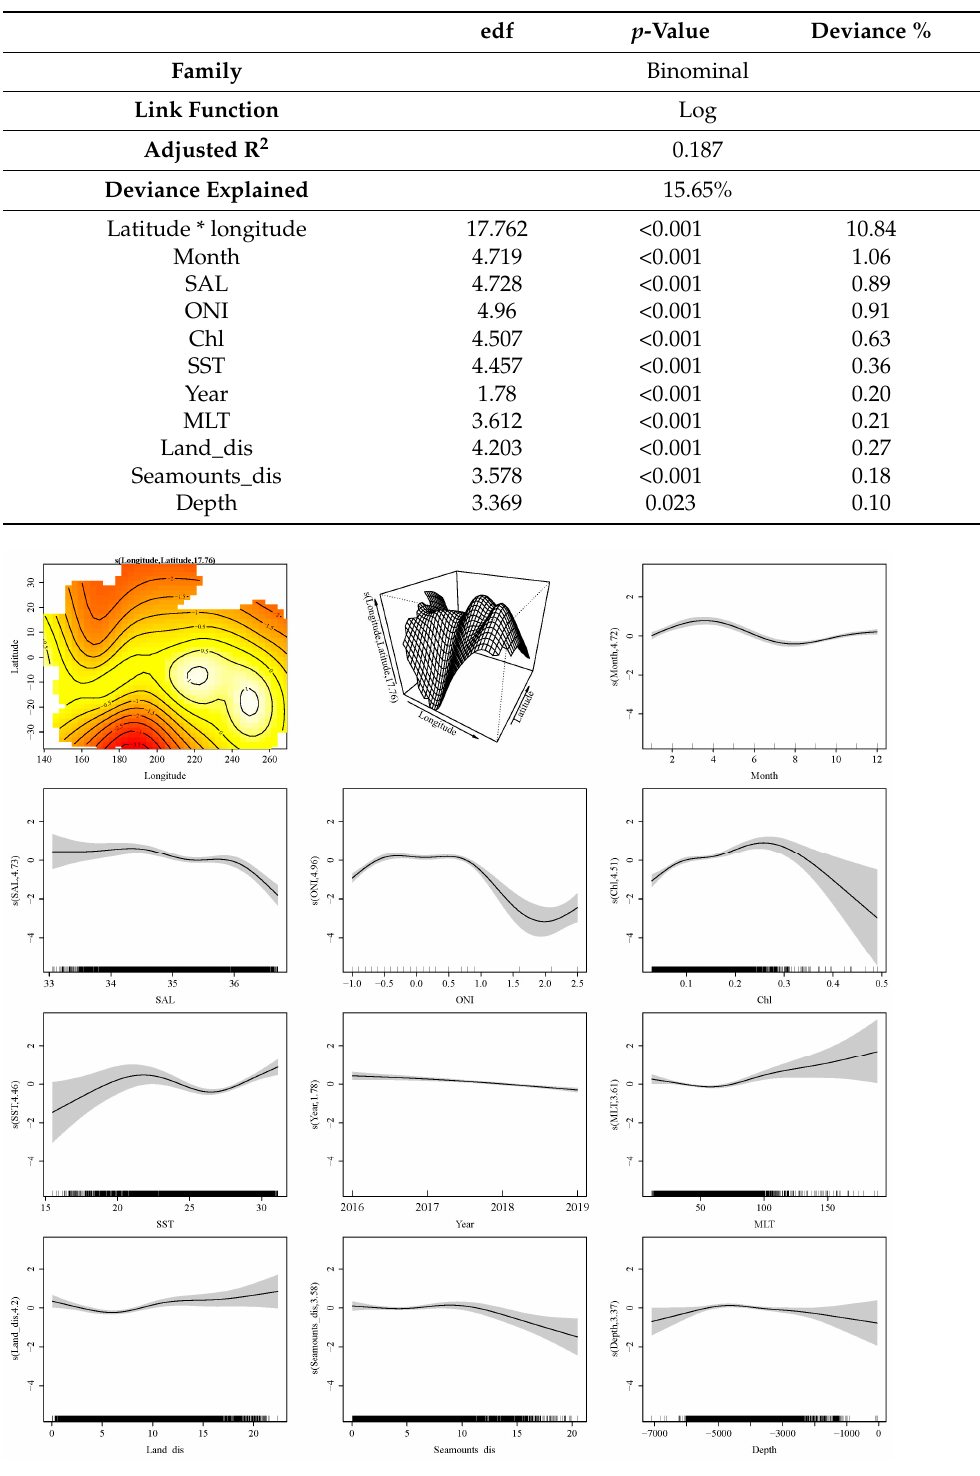
Figure 3. Effects of the spatial–temporal and environmental variables on the presence of P. violacea in the Pacific Ocean. Based on the predicted spatial distribution of the presence probability of P. violacea from the best model, the following four areas with a concentrated distribution of grids (1° × 1°) with a high probability of presence ( ≥ 0.7) were identified as potential habitats: A1